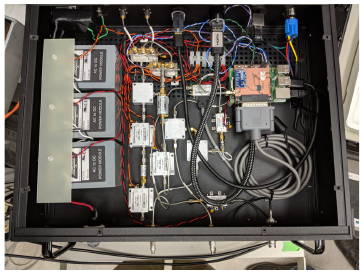
Figure 1. A custom analog electronics system for monitoring and tuning the total power level of radio frequency signals in Project 8. A Raspberry Pi (visible in the upper right) uses an I 2 C compatible sensor to monitor power levels and provides digital control logic signals via GPIO to keep the system tuned within a desired range. The entire system is able to be deployed near the relevant hardware systems and the Raspberry Pi communicates over a local area network running the same control software as x86-based